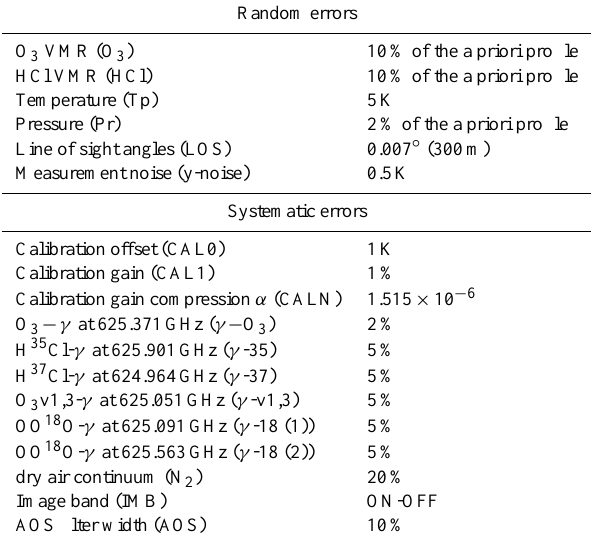
Table 5. Uncertainties assumed for single profile error estimation. The name of the parameters and the labels used for their identifica- tion in the figures are given in the parenthesis in the first column. The parameter γ is for the line pressure-broadening